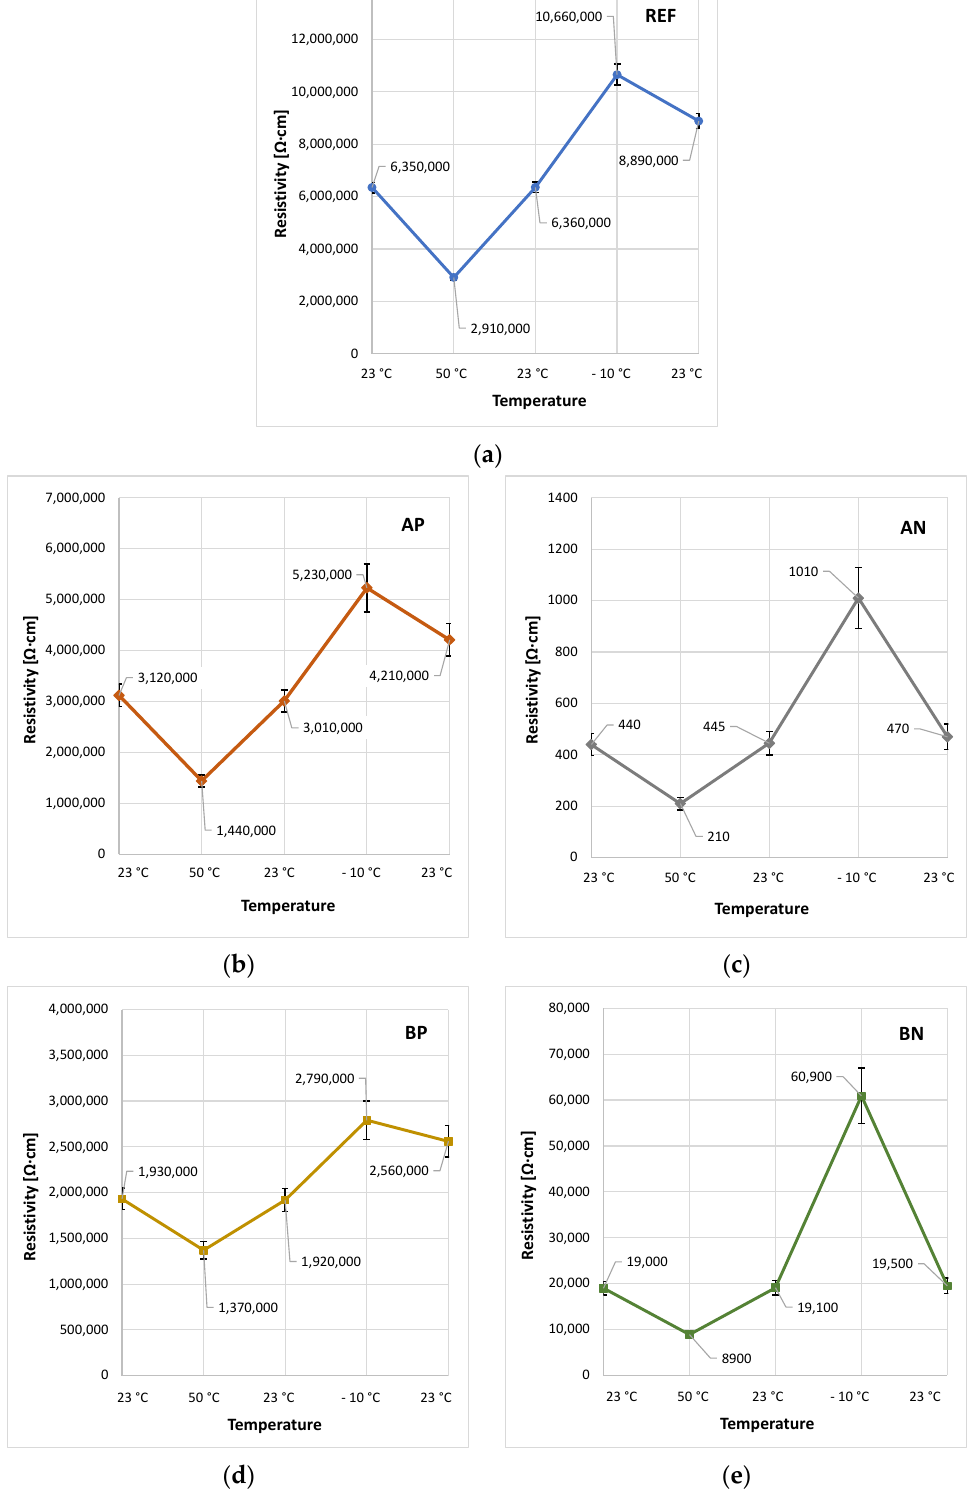
Figure 6. Dependence of resistivity on temperature for mixtures ( a ) REF; ( b ) AP; ( c ) AN; ( d ) BP; ( e ) BN.